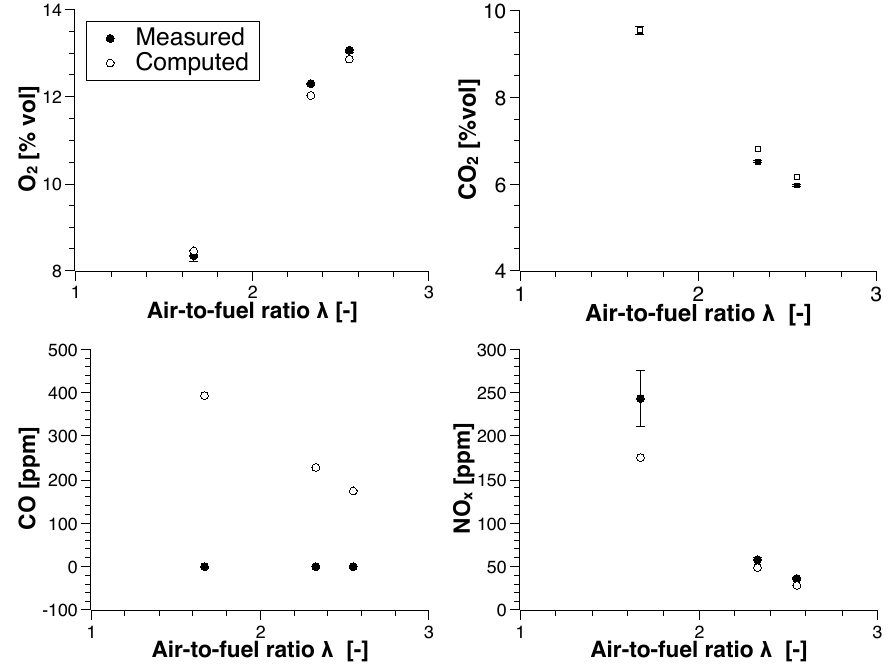
Figure 21. Comparison between the concentrations of O 2 (% vol), CO 2 (% vol), CO (ppm), and NO x (ppm) measured and the one predicted with the numerical model for different values of air-fuel equivalence ratios. Air inlet temperature 700 ◦